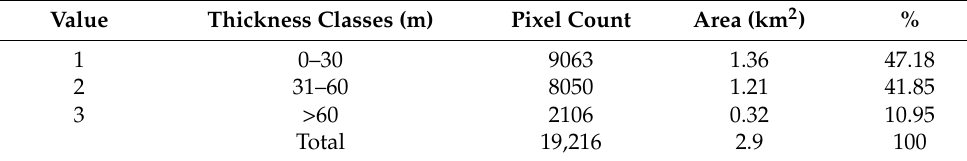
Table 4. Thickness classwise area in Harmukh